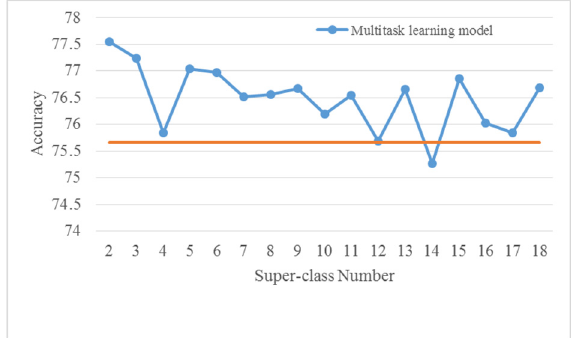
Figure 6. Accuracies of multitask learning models with different super-class numbers using CQT spectrograms on the LITIS Rouen dataset. The orange horizontal line means the accuracy of the basic model (VGG-CQT).